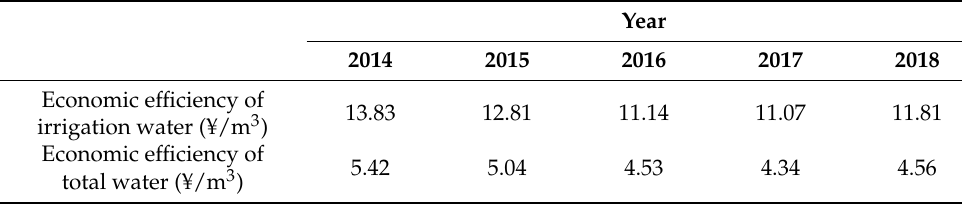
Table 7. Economic efficiency of water use in